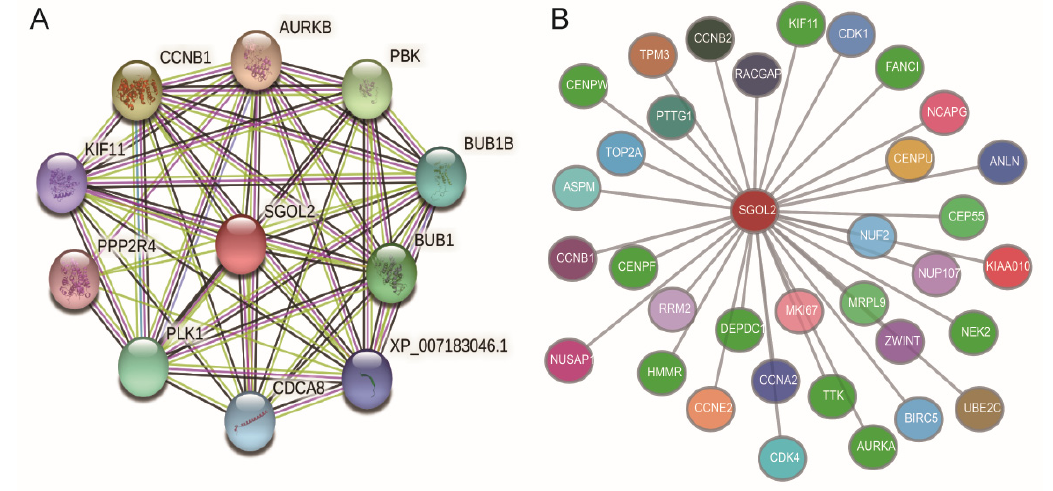
Figure 5. Hub genes of the PPI network ( A ). Construction of the gene co-expression networks ( B ). PPI, protein–protein interactions; SGOL2, shugoshin-like 2 (otherwise called shugoshin 2; SGO2).